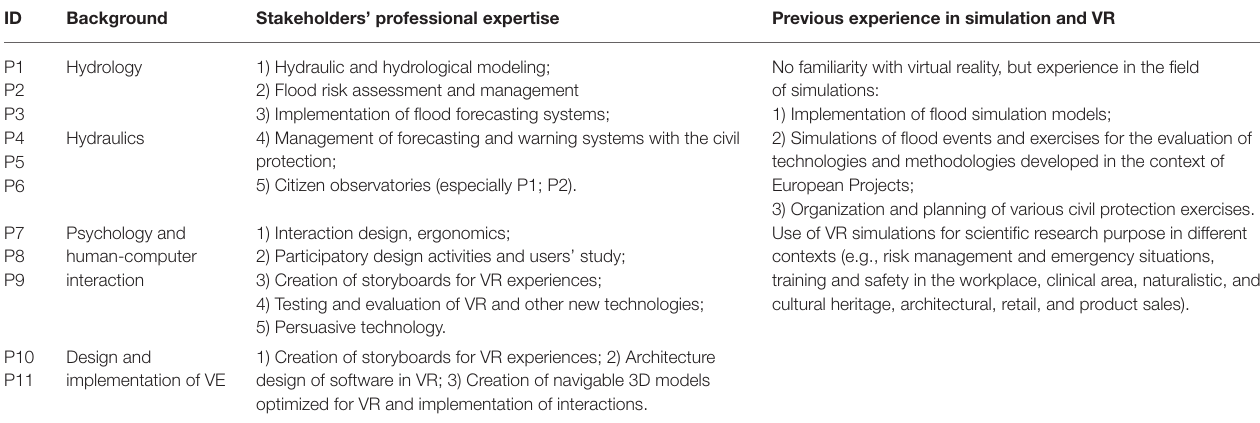
TABLE 1 | Description of the stakeholders involved in the co-design activities: field, expertise, and previous experience in simulation and VR. ID